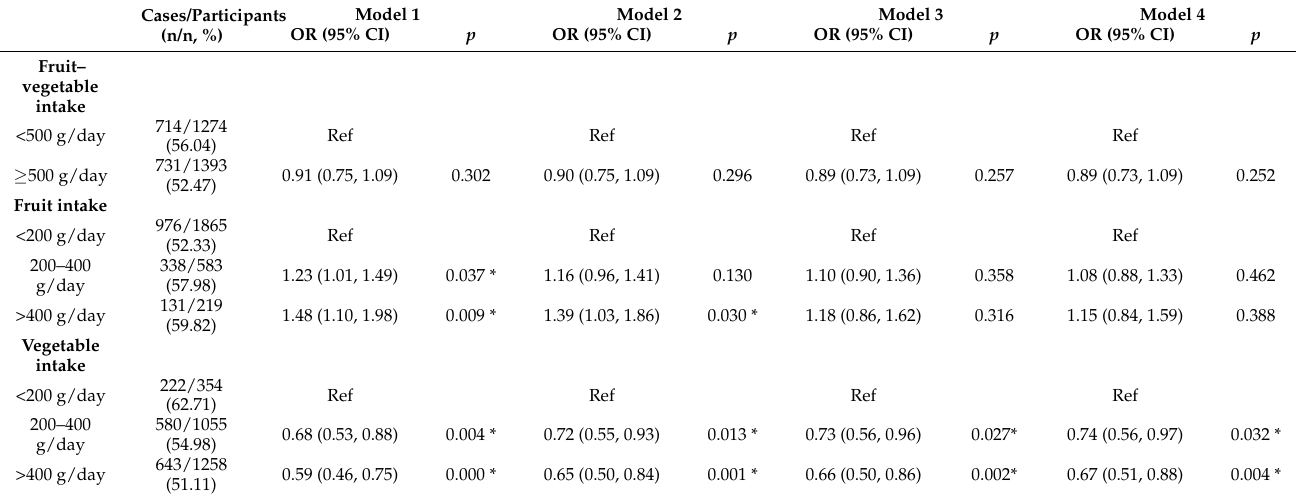
Table 2. Odds ratios with 95% confidence intervals for nonalcoholic fatty liver disease according to daily fruit–vegetable intake.